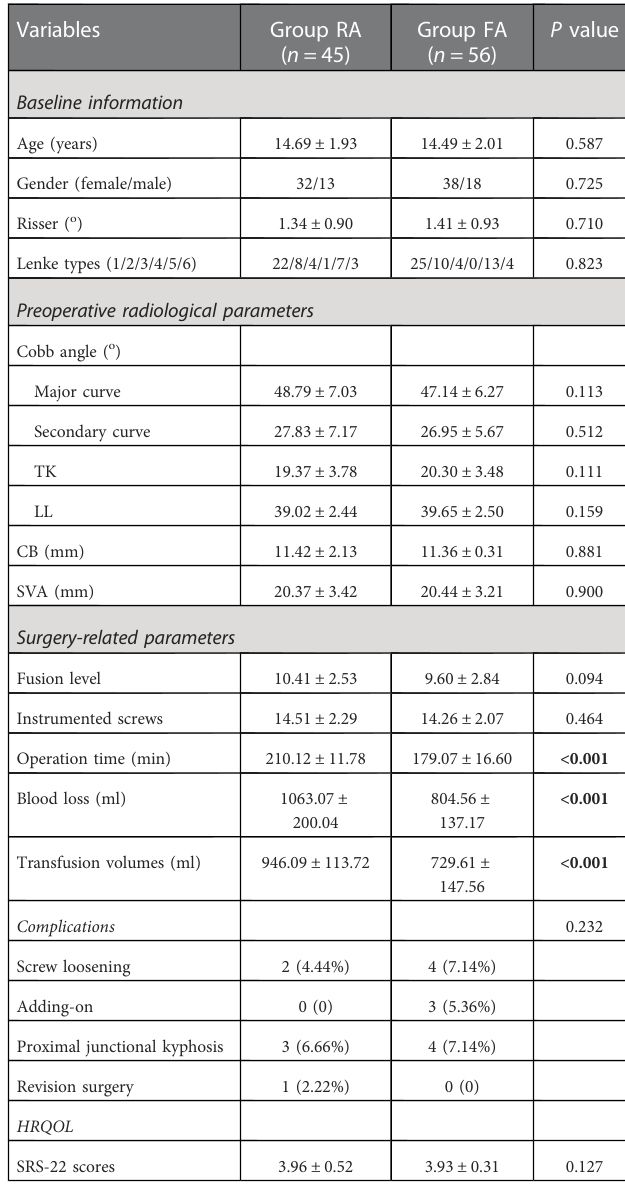
TABLE 1 The baseline information, preoperative radiological parameters, surgery-related parameters, complications and HRQOL in two